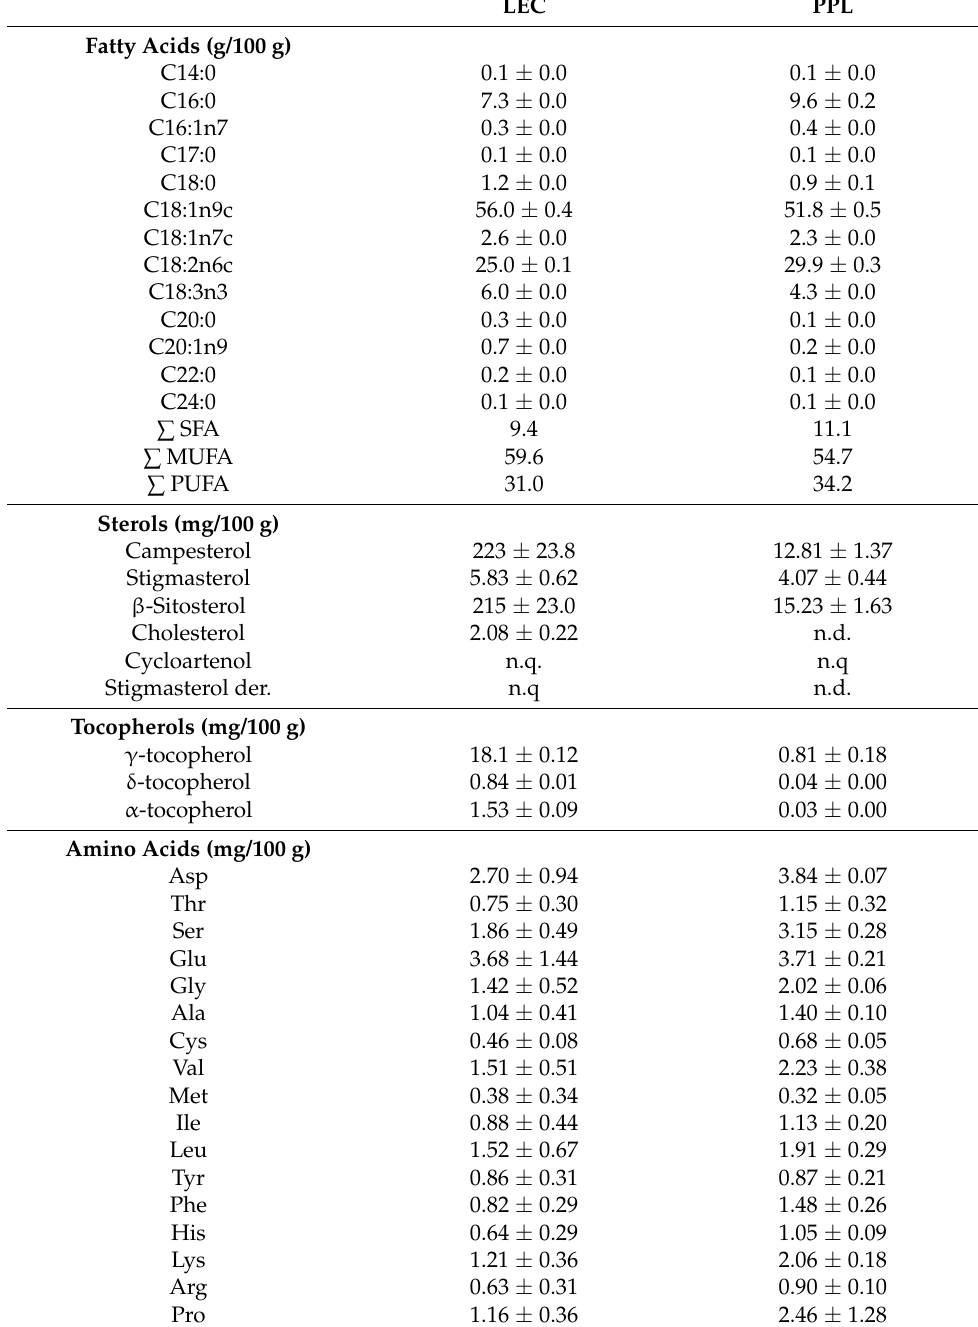
Table 1. Chemical composition of commercial rapeseed lecithin (LEC) and partially purified phos- pholipid fraction